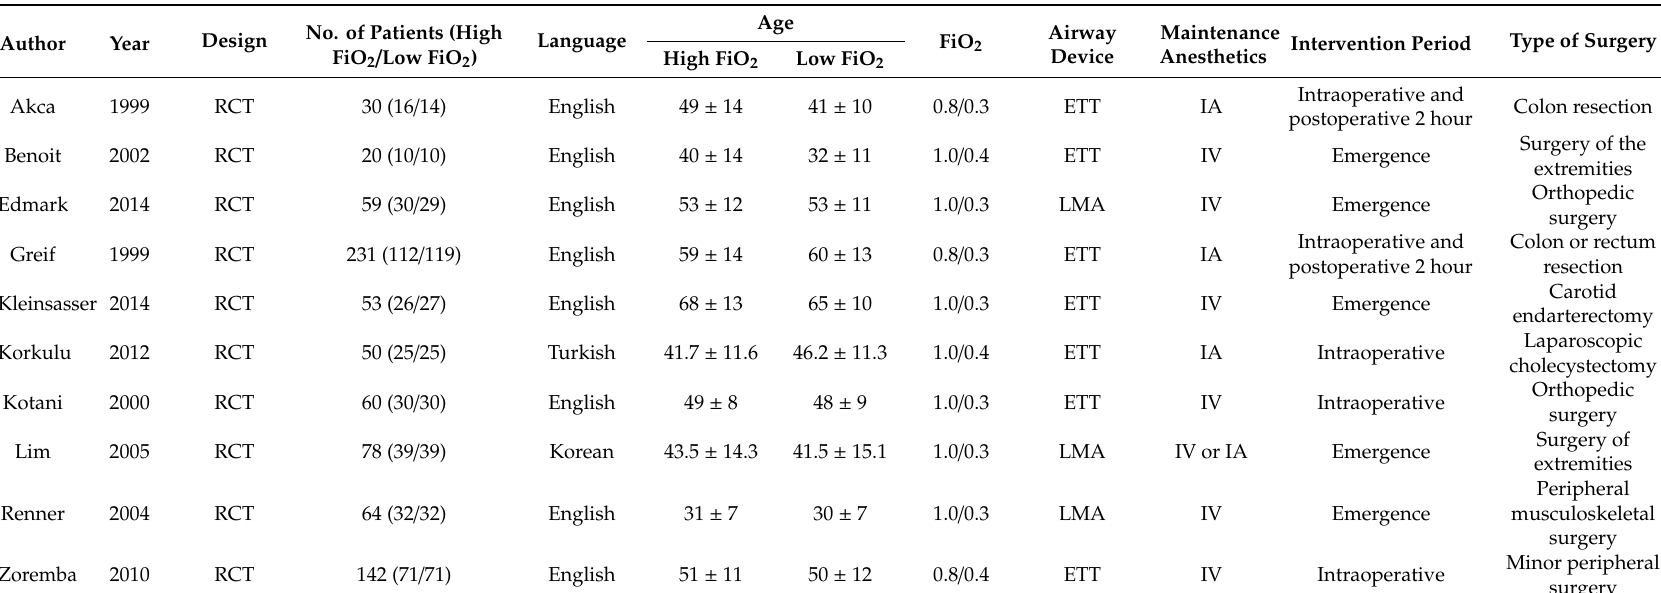
Table 1. Baseline characteristics and population of the included randomized trials ( n =